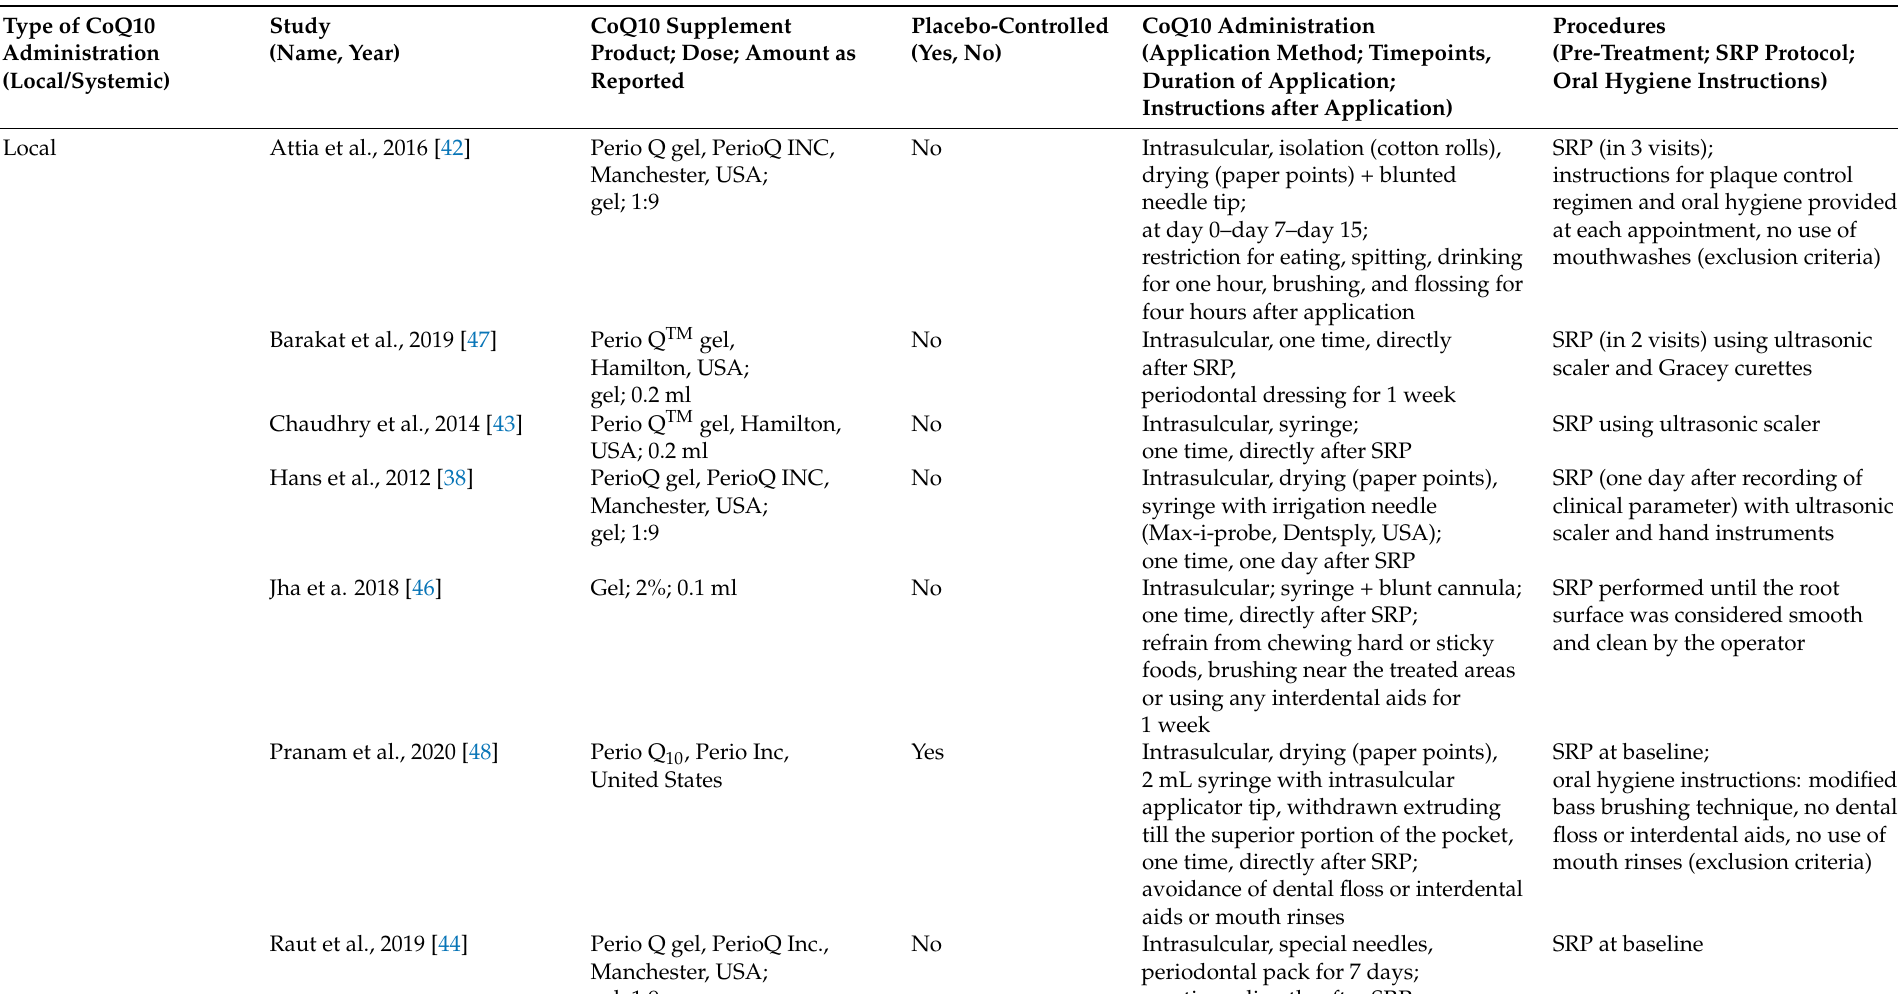
Table 2. Treatment modalities including details on the provided coenzyme Q10 (CoQ10) supplement, placebo as a control, CoQ10 administration, and scaling and root planing (SRP) procedure. Missing information in the table indicates that no according information was reported in the